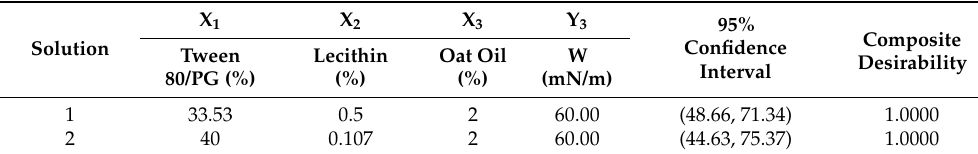
Table 13. Response optimization for work of adhesion (W), with two possible solutions, by minimiz- ing the response to 60 mN/m.